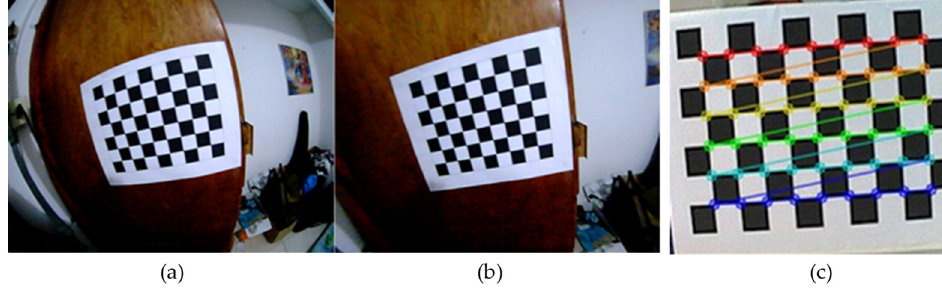
Figure 16. ( a ) Example of a distorted image. ( b ) Corrected image. ( c ) Corner detection on the calibration chessboard.